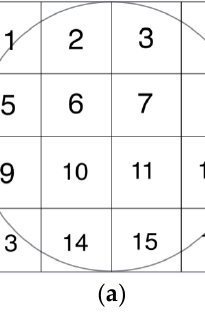
Figure 2. ( a ) The image of pixel unit ( b ) The movement of the object in the simulated domain.